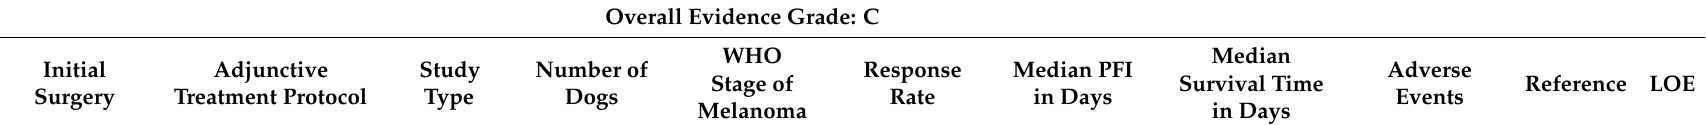
Table 7. Summary of hyperthermia studies evaluating effectivity in oral malignant